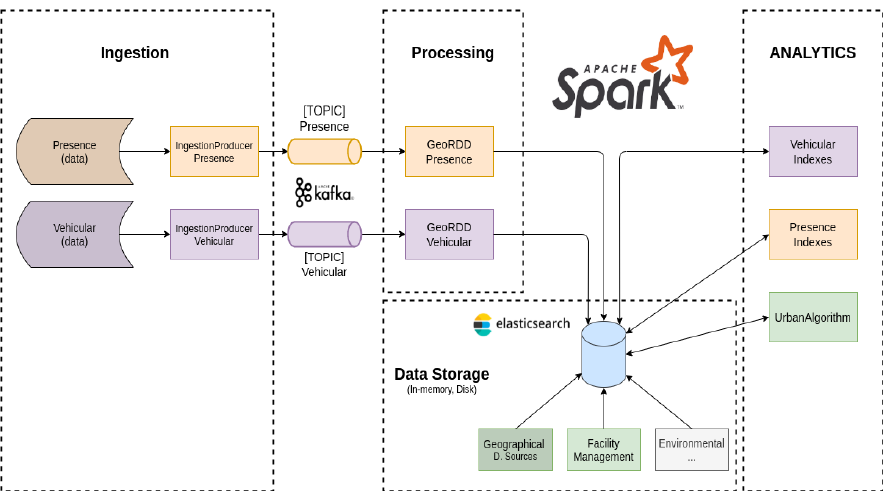
Figure 3. IPPODAMO (big) data processing pipelines and information